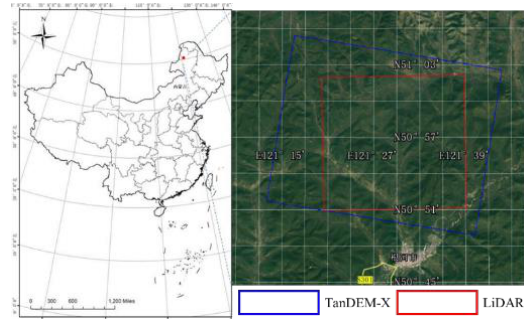
Figure 1. Scope of study area and range of remote sensing